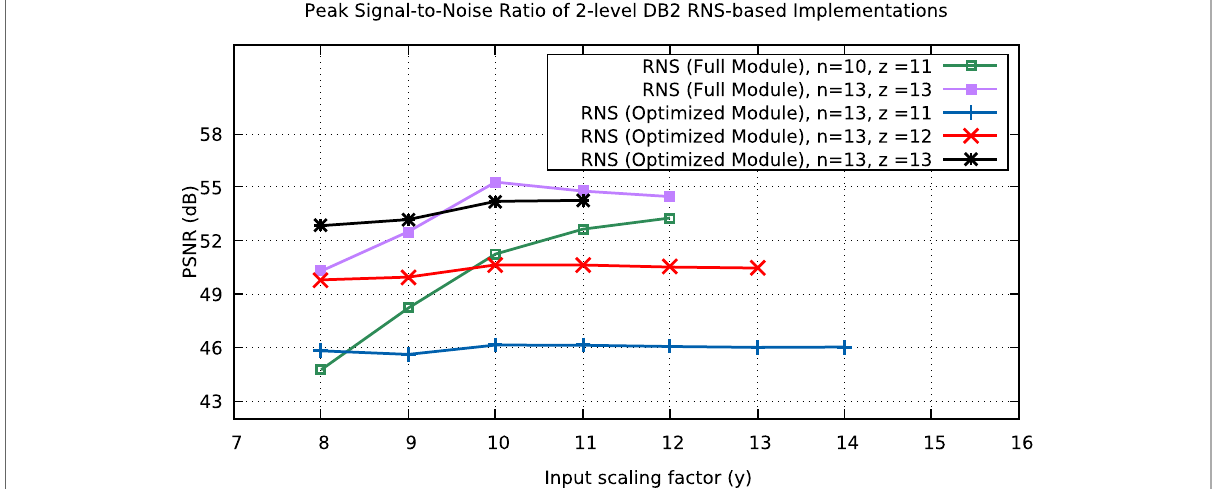
Fig. 13 The impact of input, y , and wavelet filter coefficients, z , scaling factors of two-level RNS-based implementation with respect to P 10 and P 13 moduli sets on PSNR